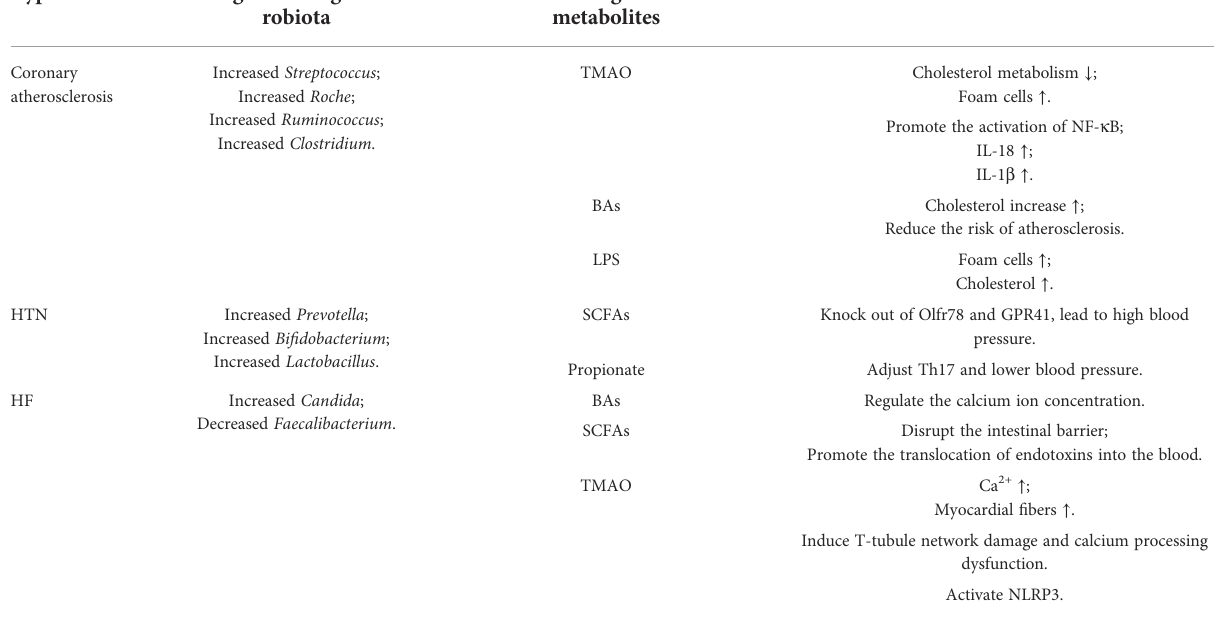
TABLE 1 The association between gut microbiota and